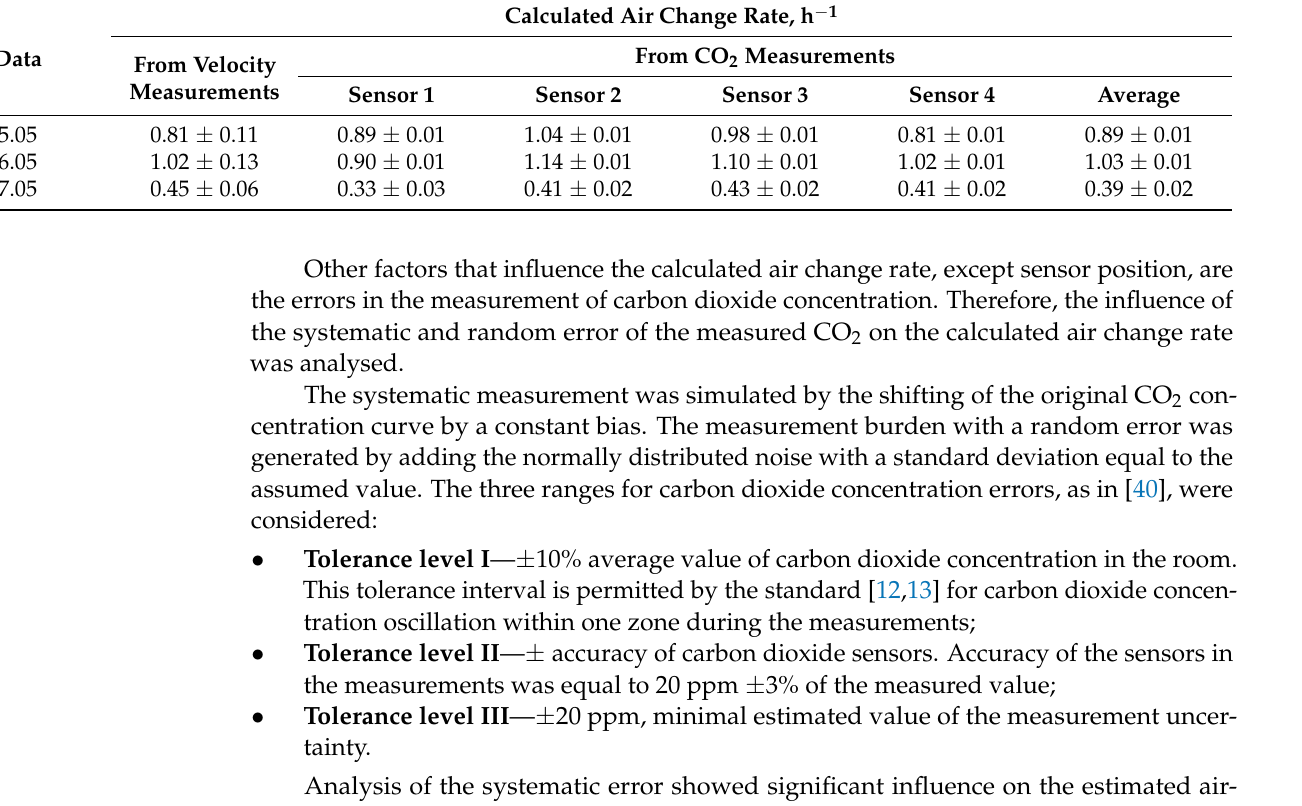
Table 1. Comparison of calculated air change rate from velocity measurement with air change rate estimated from CO 2